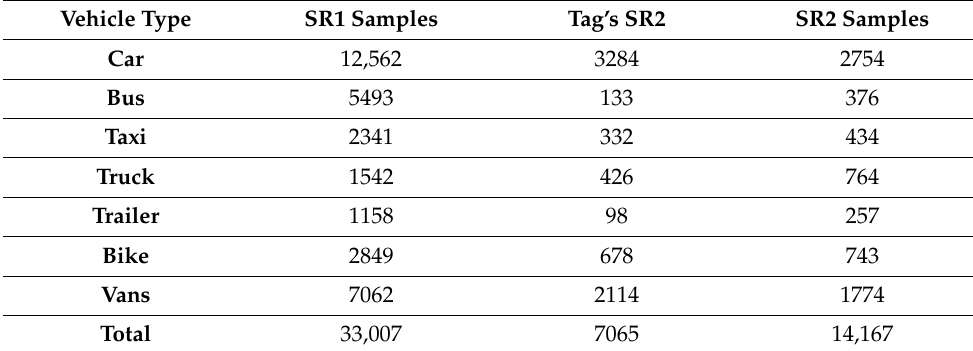
Table 3. Sampling for cars, buses, taxis, trucks, trailers, bicycles, vans.